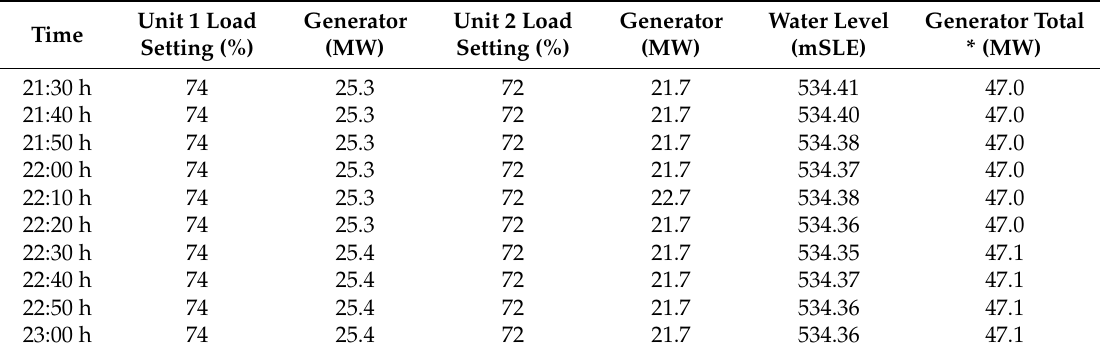
Table 5. Snapshots of controller maintaining a high load with reducing water